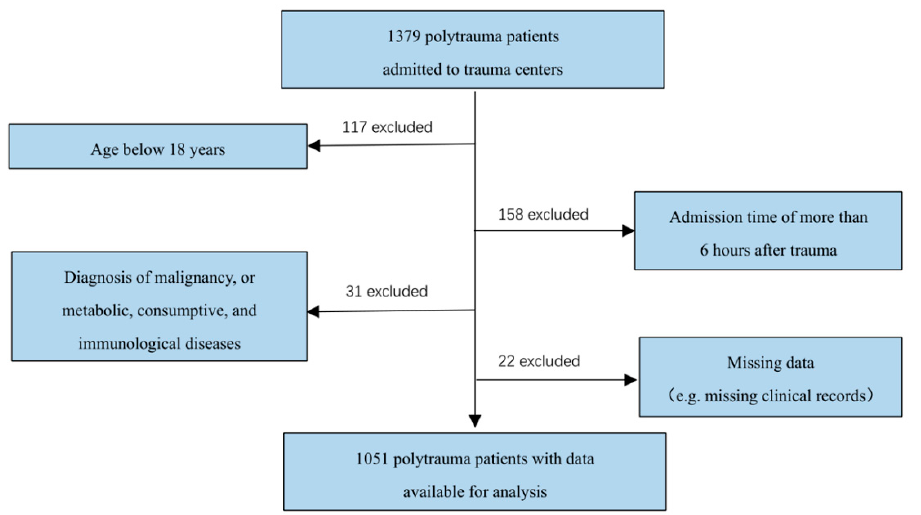
Figure 1. Case identification procedure. Table 1. Demographics and characteristics of polytrauma patients.